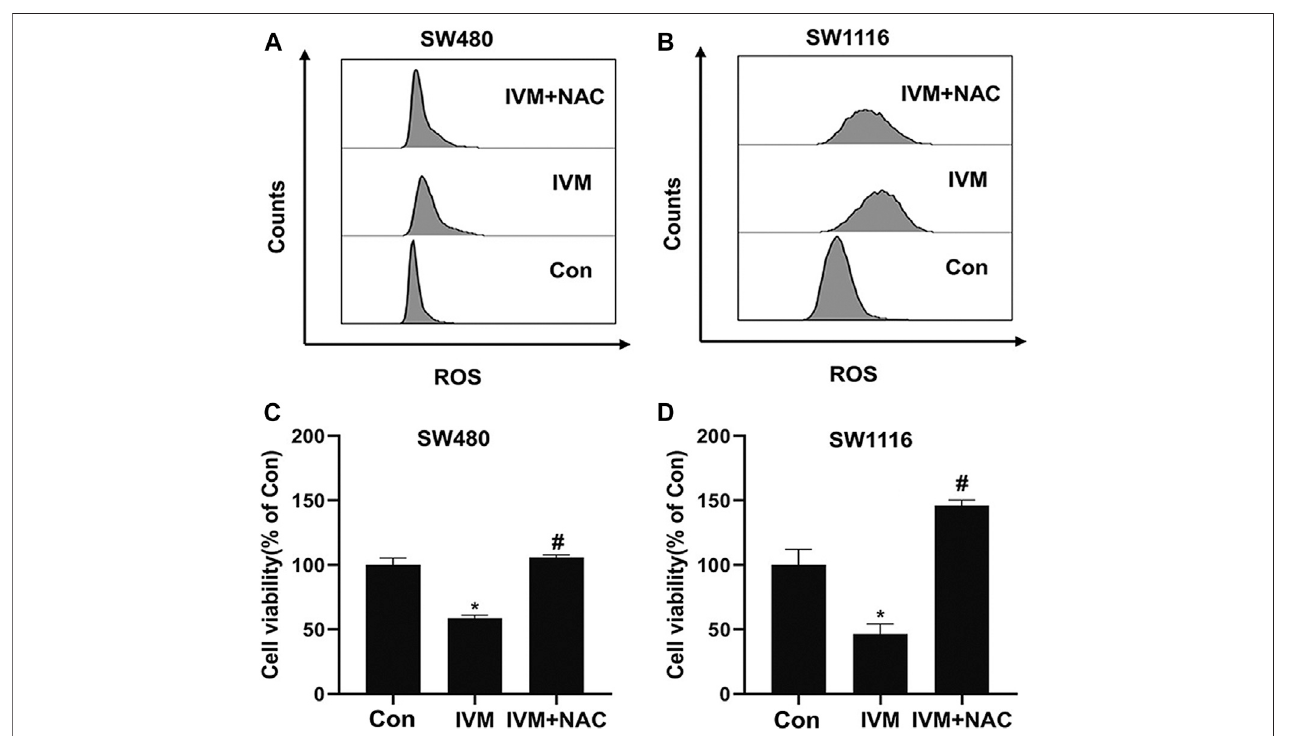
FIGURE 9 | NAC reversed ivermectin-induced ROS and cell death in colorectal cancer cells. After SW480 (A, C) and SW1116 (B, D) cells were pretreated with ROS inhibitor NAC (5 mM) for 1 h and then were cultured in ivermectin (20 μ M) for 6 h, they were stained by MitoSOX and detected by fl ow cytometry. The experiment wasrepeatedthreetimes,andrepresentativehistogramimageswereshownin (A,B) . (C) and (D) ,afterSW1116andSW480cells,werepretreatedwithNAC(5 mM)for 1 h and then were cultured in ivermectin (20 μ M) for 6 h; the CCK-8 assay was performed to determine the cell viability described as the “ Material and Methods ” section. The experiment was performed three times with three biological replicates in each group. * p < 0.05, compared with the control group (0 µM). # p < 0.05, compared with the IVM group. IVM, ivermectin; NAC,